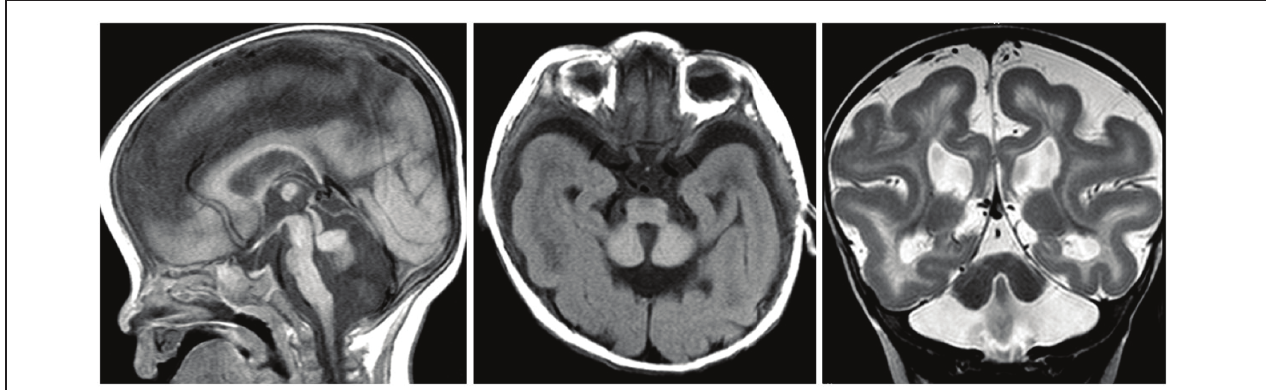
FIGURE 2 | RELN mutation. Sagittal (left panel) and axial T1- (middle panel), and coronal T2-weighted (right panel) images showing a very small afoliar vermis and cerebellar hemispheres. The severe hypoplasia of the cerebellum